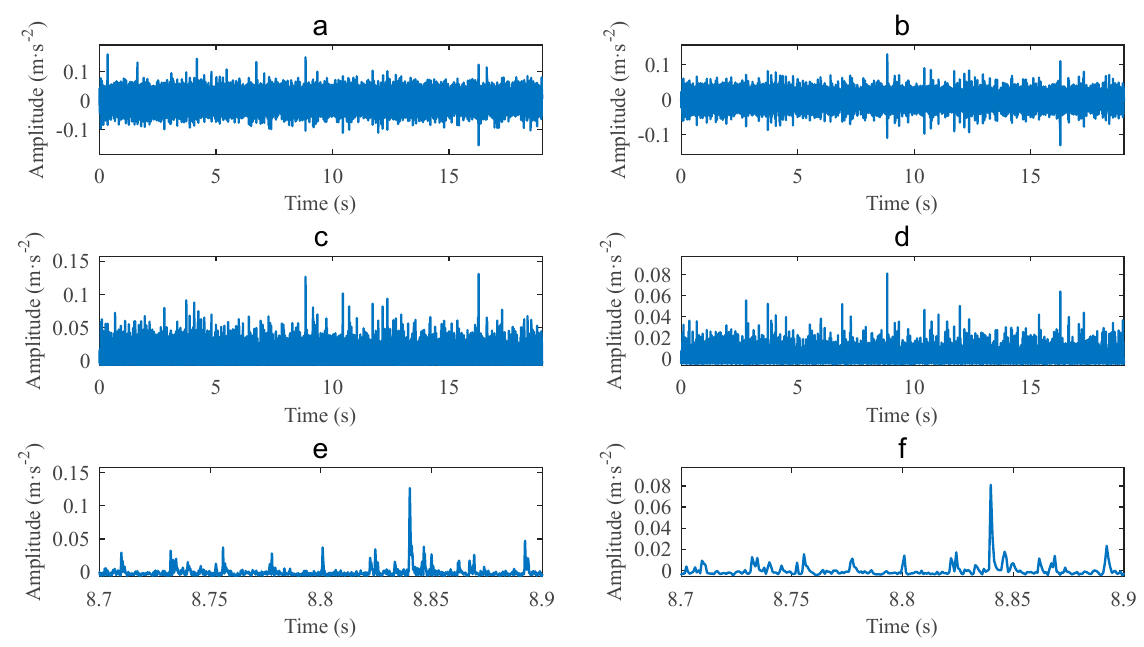
Figure 6. Case 1 for outer race defect: ( a ) Original signal; ( b ) filtered signal; ( c ) envelope; ( d ) compressed signal; ( e ) partial enlarged envelope; ( f ) partial enlarged compressed